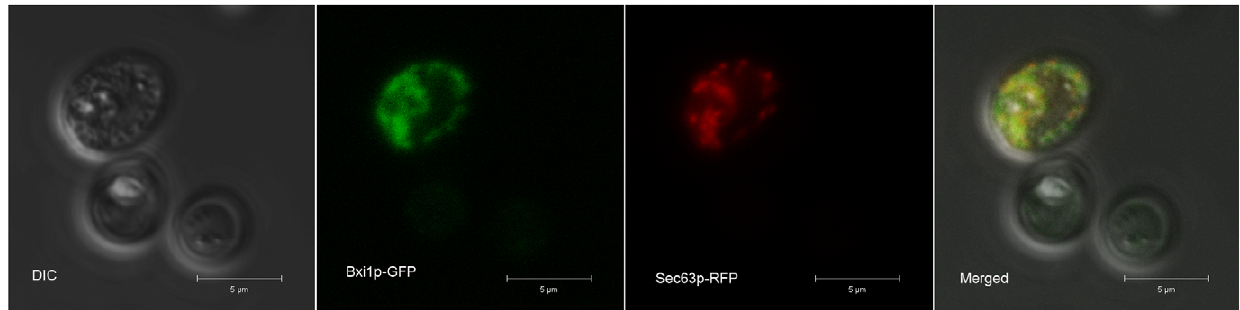
Figure 4. Yeast Bxi1p colocalizes with Sec63p, a marker for the endoplasmic reticulum. Wildtype cells containing both GFP-Bxi1p and RFP-Sec63p were grown to mid-log phase in selective media and examined with a Zeiss LSM 700 Laser Confocal Microscope using a 63X oil immersion objective and a pinhole size of 1 Airy Unit. This colocalization was seen in 74% of exponentially growing cells expressing both tagged